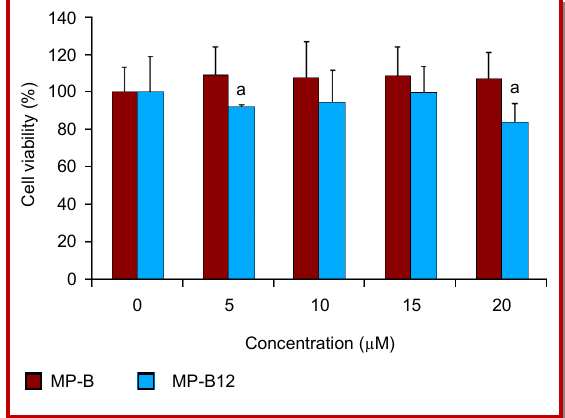
Figure 2: Effect of MP-B peptides on cell viability in 3T3-L1 cells. The cells were cultured with MP-B and MP-B12 (0~20 μ M). The data were expressed as the percentage of cell viabil- ity and represented as the means ± SE of three experiments in which each treatment was performed in triplicate. a